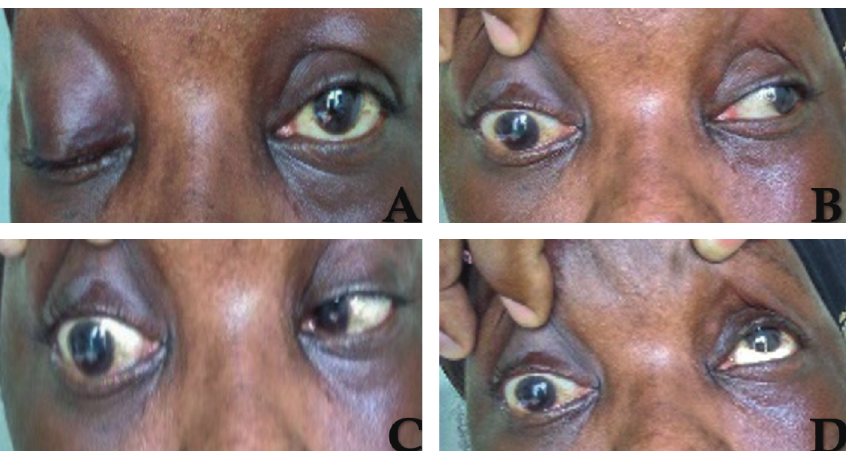
Figure 1: (a) Right ptosis. (b) Paresis of the third cranial nerve. (c) Paresis of the sixth cranial nerve. (d) Paresis of the fourth cranial nerve.